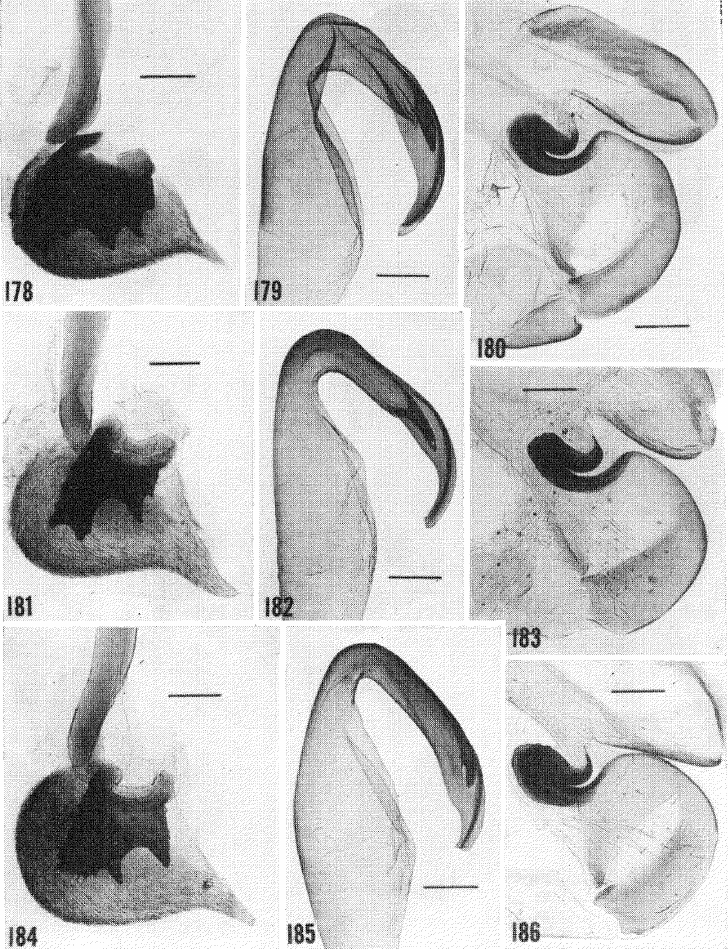
Figs. 178-186. Cockroach male genitalia. Epilampra opaca. 178-180. (38 ANSP). St. Jean du Maroni, French Guiana (det. Hebard). 181-183. (17 CUZM). Essequibo, British Guiana (det. Prineis). 184-186. (80 USNM). Amapfi, Brazil (det. as near berlandi by Albuquerque, and as sal#ta by Princis). (scale 0.2